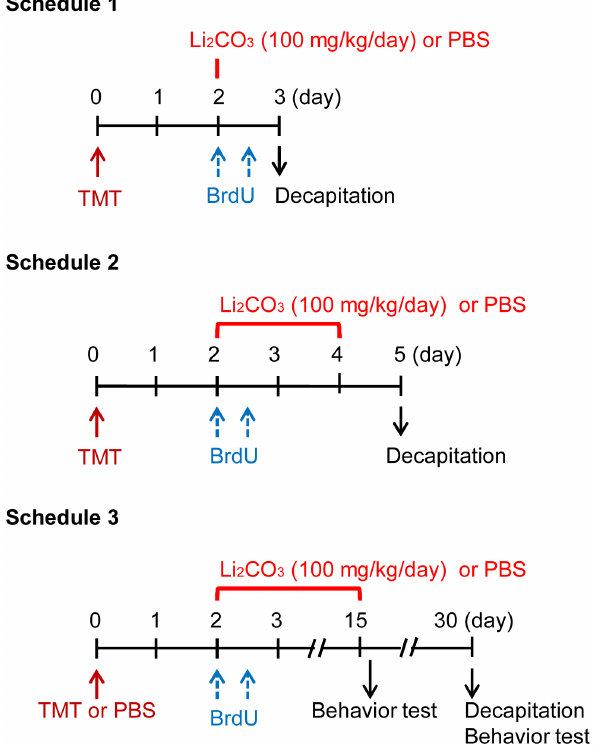
Figure 1. Experimental schedules. In ‘‘Schedule 1, 2, and 3,’’ animals were given TMT (2.9 mg/kg, i.p.), and then received 2 consecutive injections of BrdU (50 mg/kg, i.p.) with a 12-h interval between them on day 2 post-TMT treatment for labeling mitotic cells